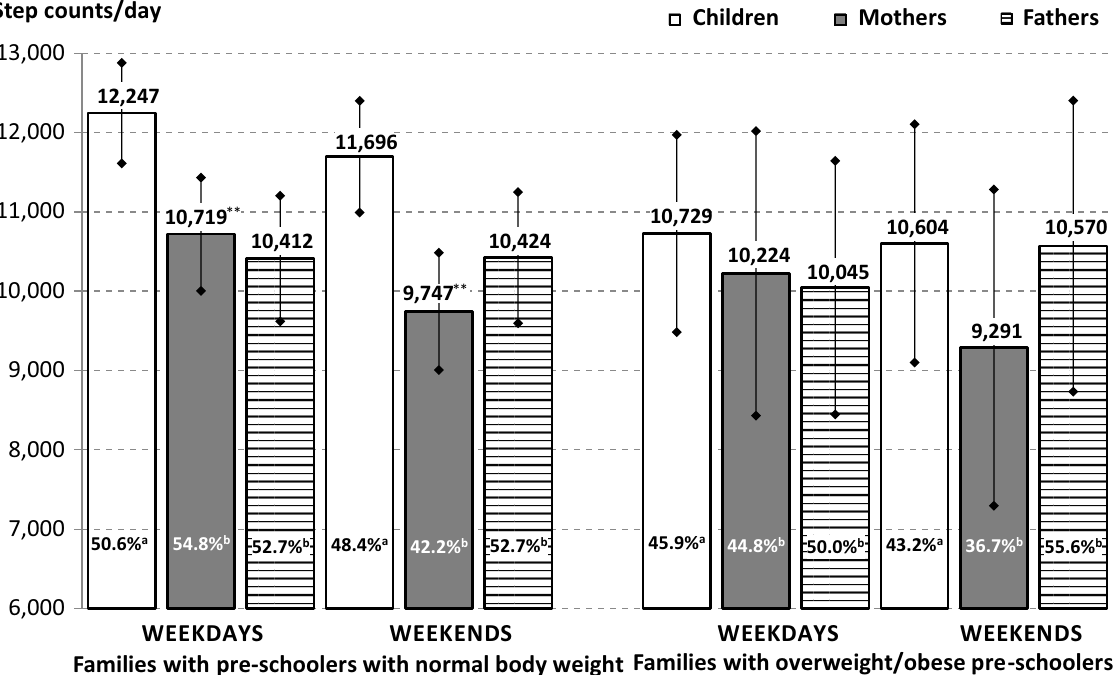
Figure 1. Comparison of parents’ and children’s pedometer-determined daily step counts (mean and 95% confidence intervals) on weekdays and at weekends. % a = percentages of children who reach the step count recommendation of 11,500 steps per day; % b = percentages of mothers/fathers who reach the step count rec- ommendation of 10,000 steps per day. The statistical significance of weekday-weekend differences in daily step counts is expressed as ** p ≤